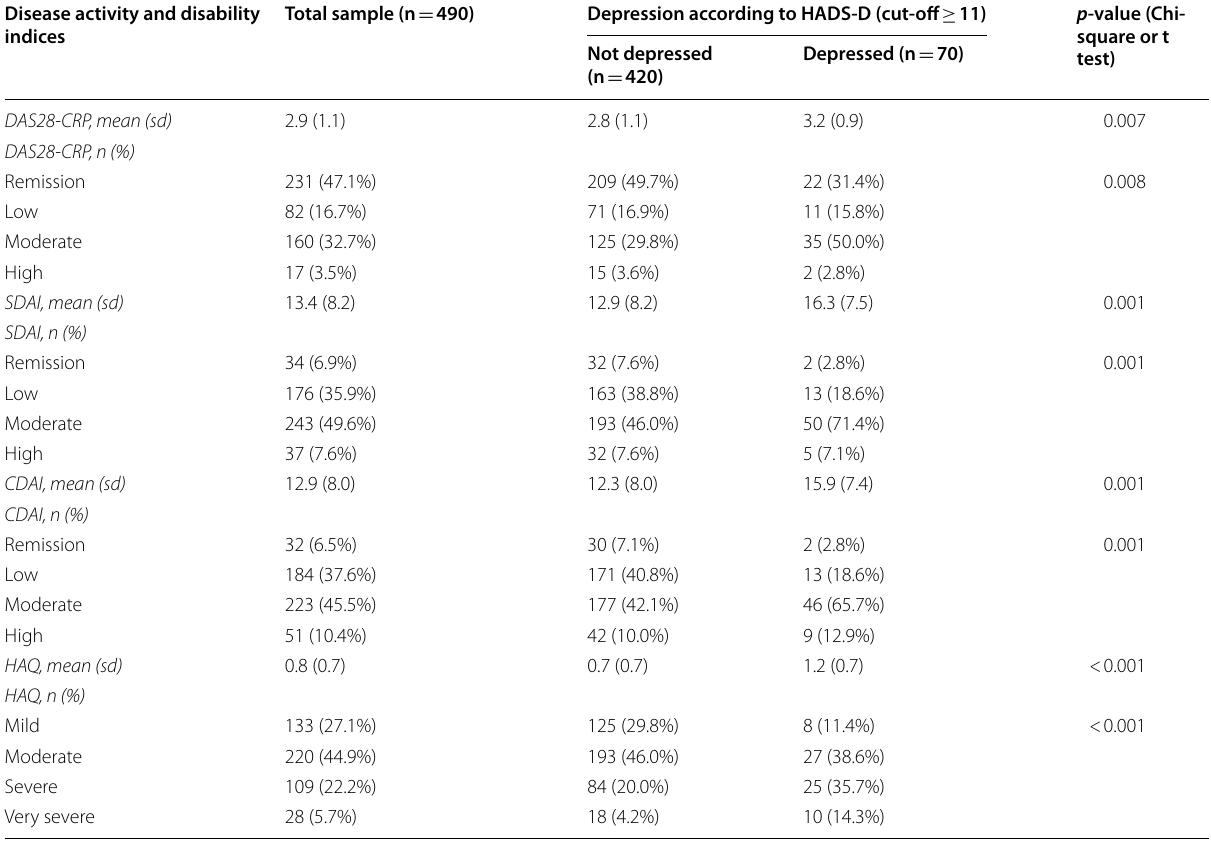
Table 5 Association between RA activity/disability and depression (n